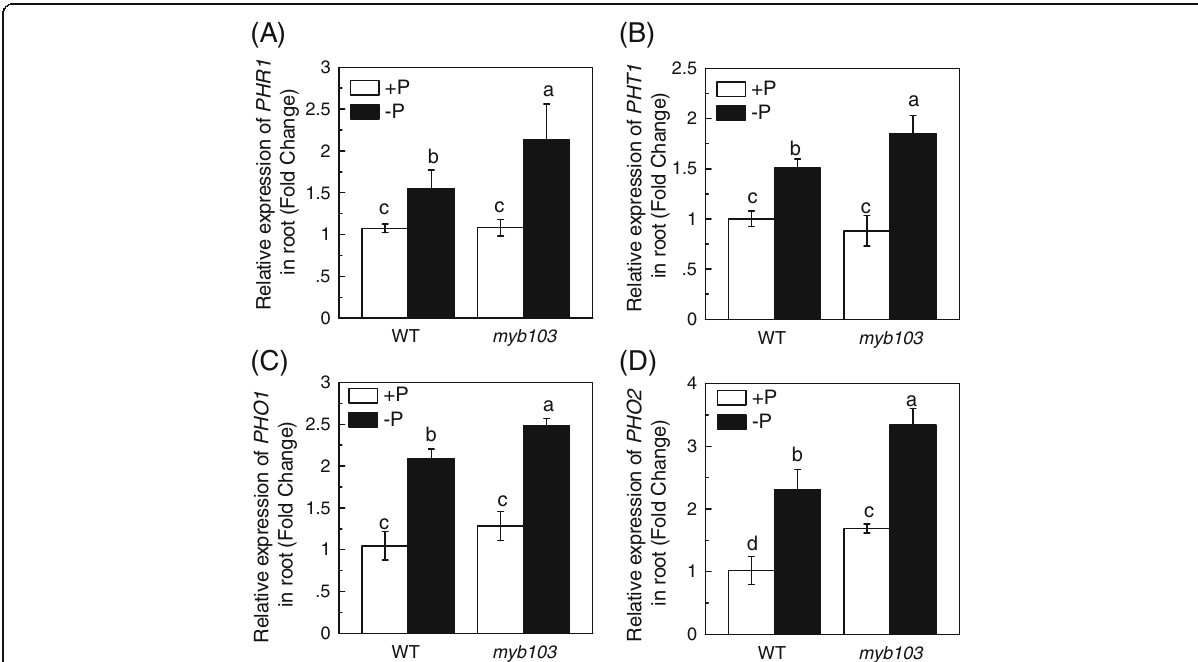
Fig. 4 Relative expression of genes involved in P acquisition and allocation in roots of WT and myb103 . Seedlings were hydroponically treated with +P or -P solution for 7 d, and roots were harvested for expression analysis